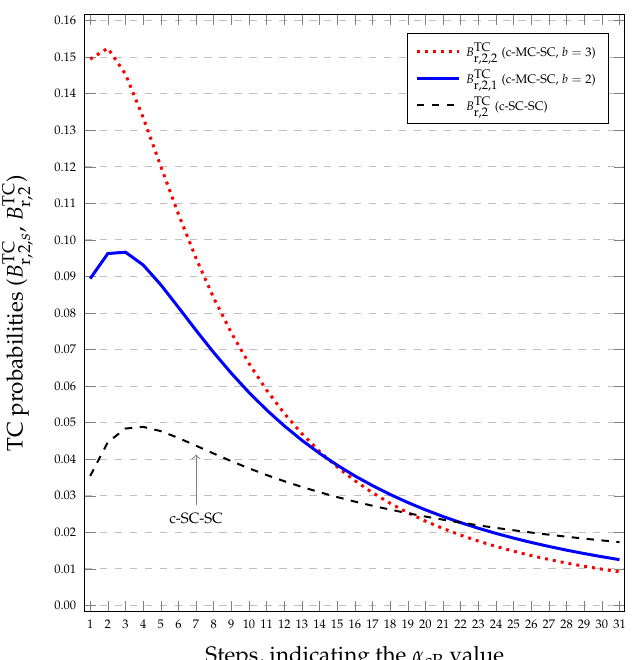
Figure 4. TC probabilities, B TC c-SC-SC).